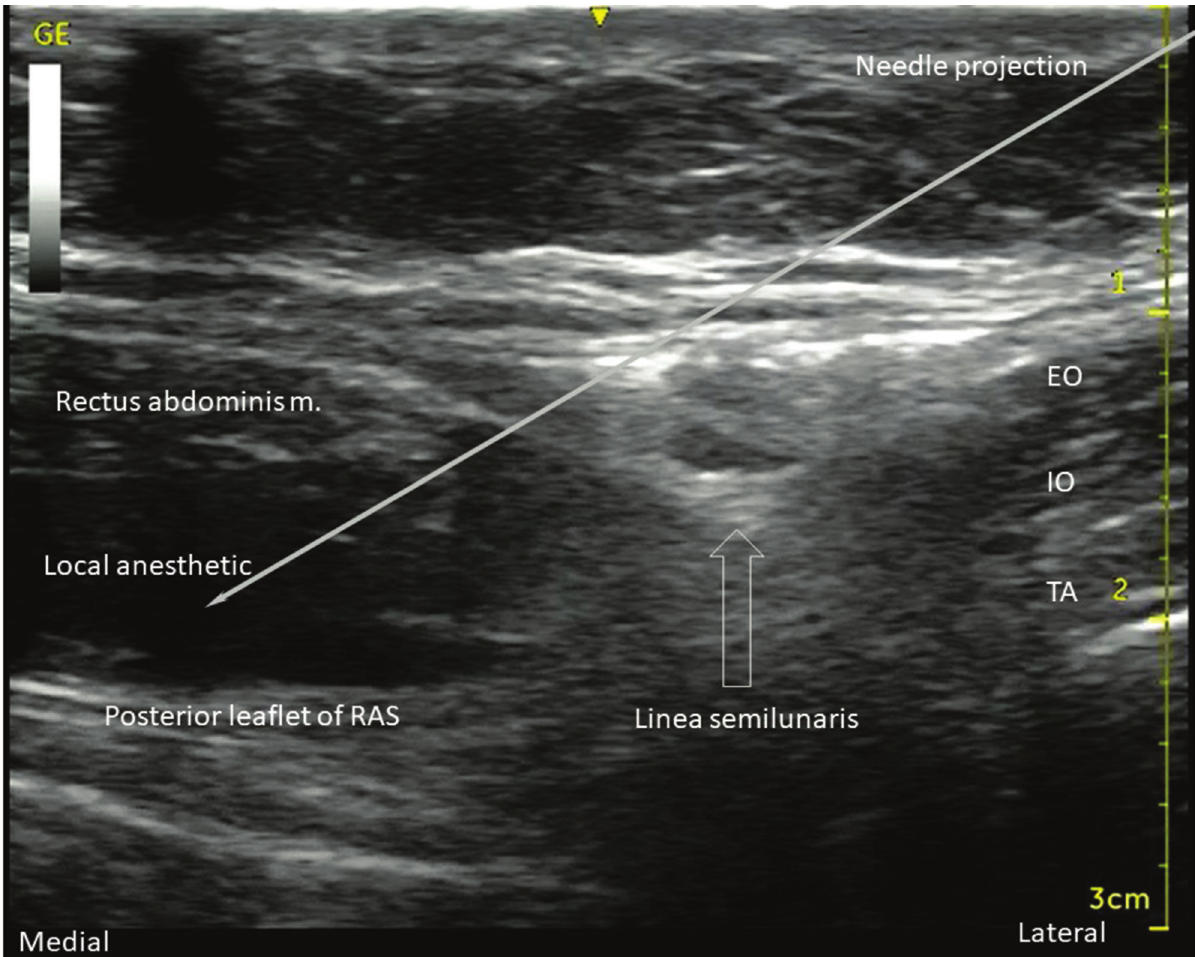
Figure 10 - US image, with the projection of the needle position, and the local anesthetic spread between the RA muscle and posterior leaflet of RAS. EO: external oblique muscle; IO: internal oblique muscle; TA: transverse abdominis muscle.